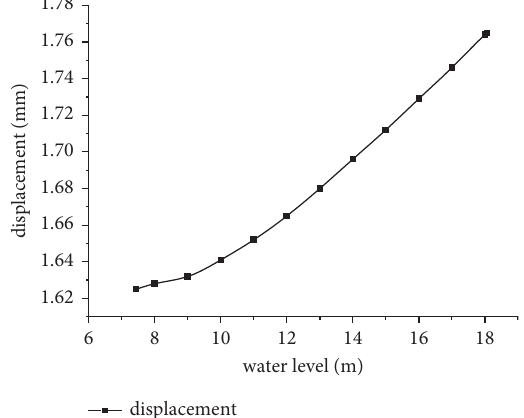
Figure 6: Maximum deformation curve of bridge pier under ship